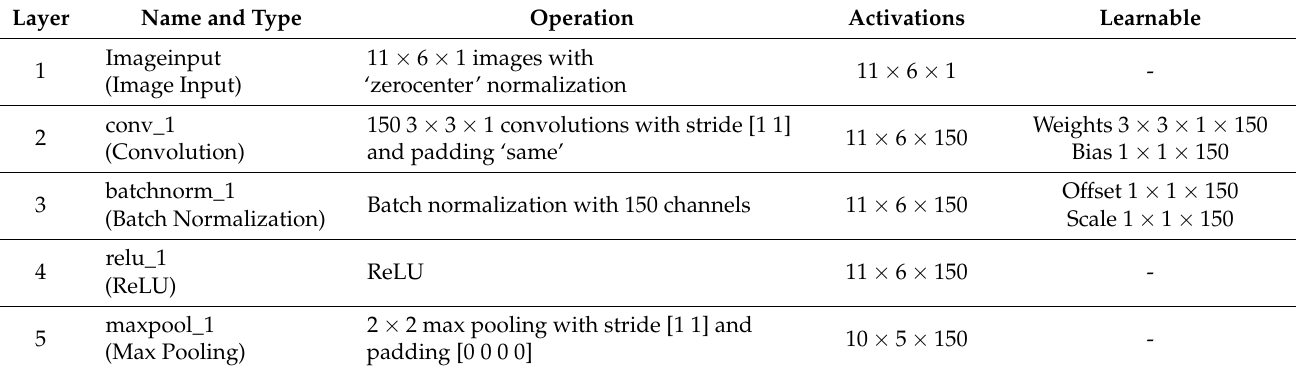
Table 3. Details of CNN (convolutional neural network) layers and parameters.